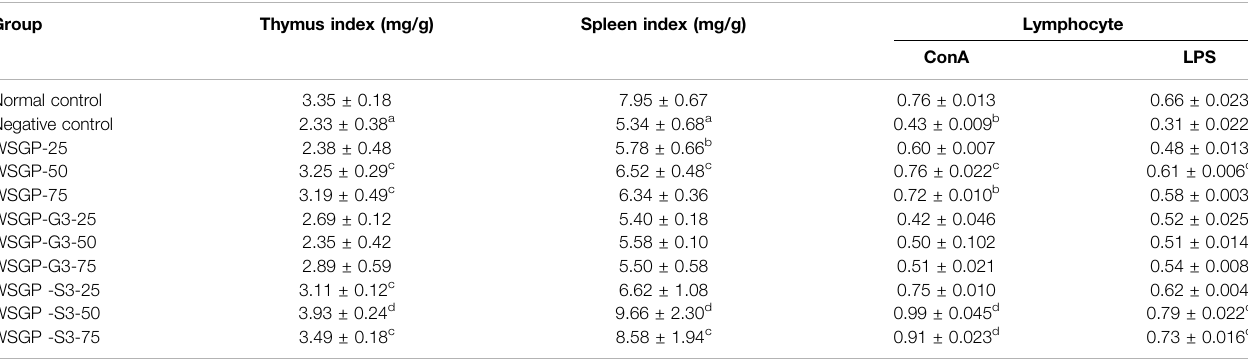
TABLE 3 | Effects of the polysaccharides on ConA- or LPS-induced lymphocyte proliferation in mouse in vivo . Group